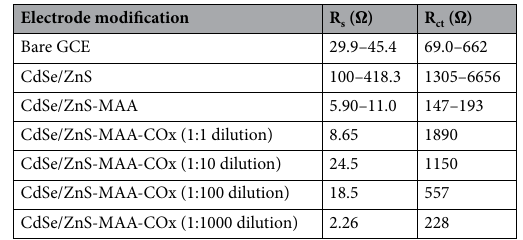
Table 1. Equivalent circuit values by fitted Nyquist plot for 1:1000, 1:100, 1:10 and 1:1 diluted Cox conjugated CdSe/ZnS